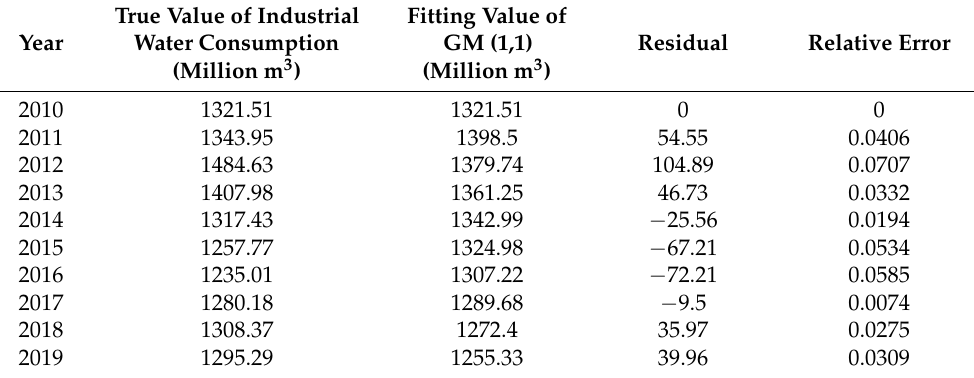
Table 9. Fitting results of industrial water demand prediction model in Changsha city from 2010 to